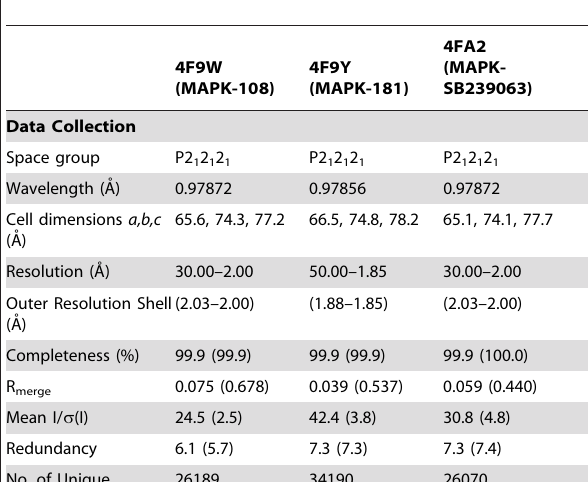
Table 1. Data collection and phasing statistics. Values in parentheses are for highest resolution